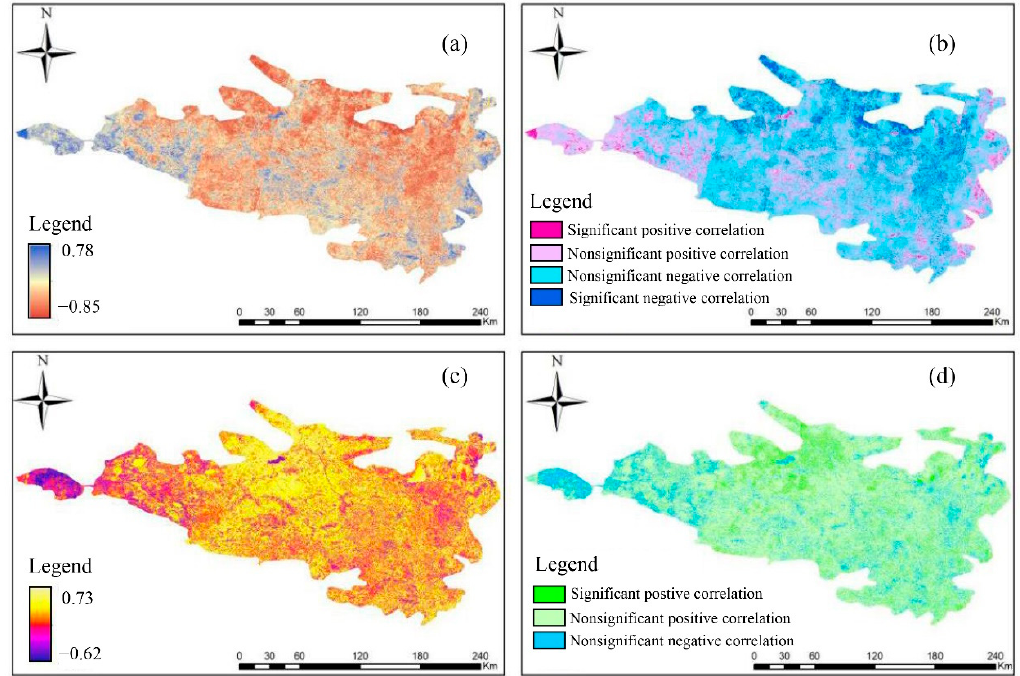
Figure A4. Spatial distribution of correlation between annual precipitation, annual mean temperature and desertification index in OSL. ( a ) Correlation of precipitation; ( b ) Correlation significance of precipitation; ( c ) Correlation of temperature ( d ) Correlation significance of temperature.